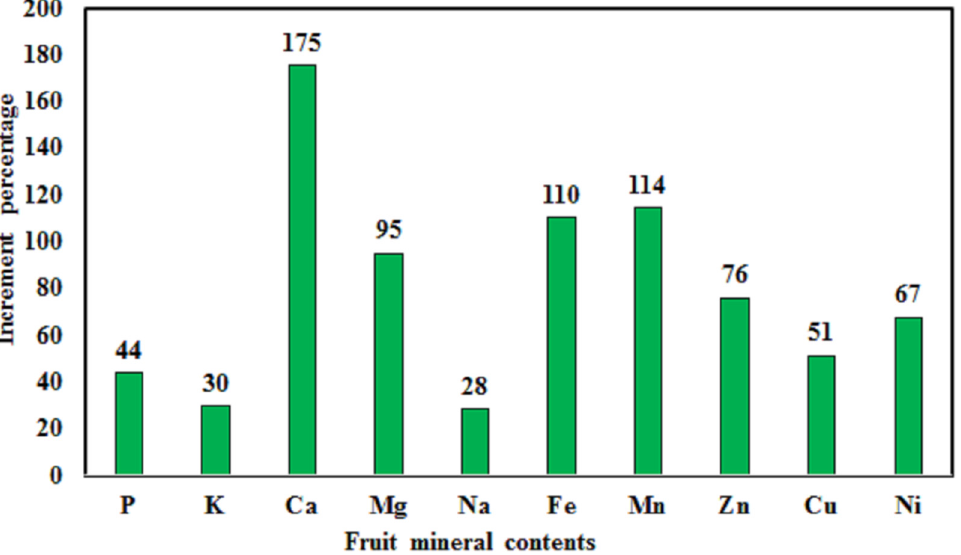
Figure 7. Increment percentage of fruit mineral content when Ca(NO 3 ) 2 :(NH 4 ) 2 SO 4 ratios are integrated by 30%:70% compared to ratio 0%:100%.